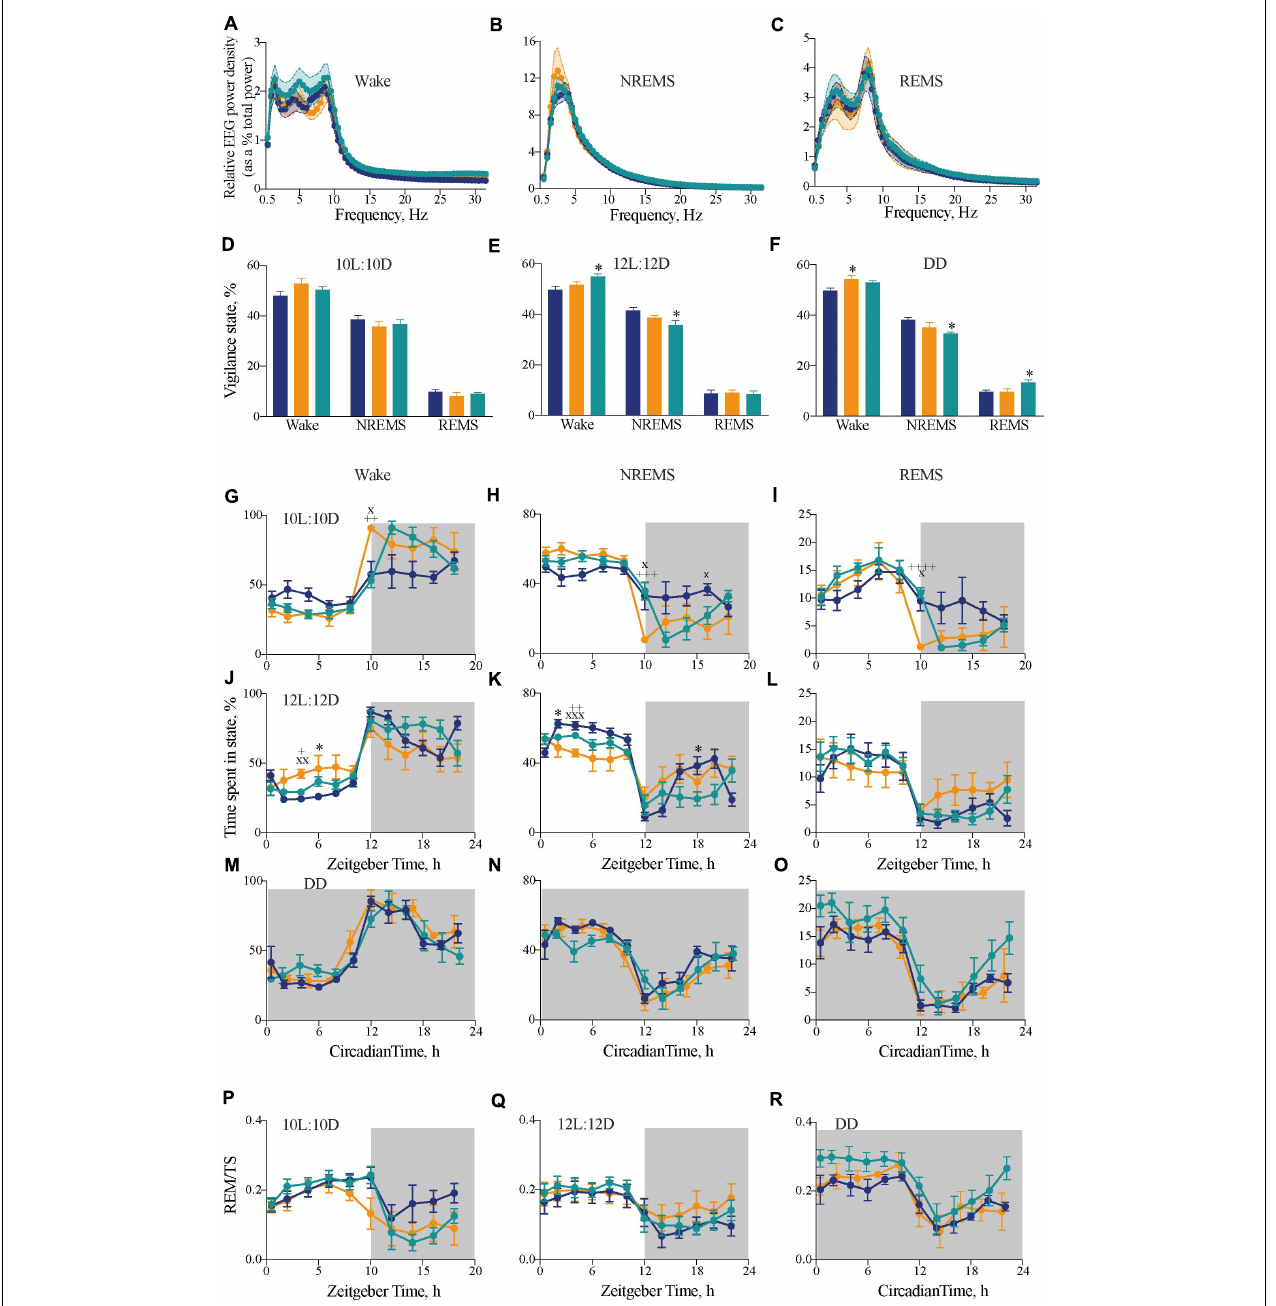
FIGURE 3 | Impact of circadian chimerism on sleep-wake cycles. (A–C) Mean ( ± SEM) relative EEG spectral power (as a percentage of total EEG power) across 0–30 Hz in wake (A) , NREMS (B) , and REMS (C) over a circadian cycle. WT (blue), Tau (orange), and chimeric (green) mice (two-way ANOVA with post hoc Tukey’s multiple comparisons test; no significant effects between Genotype or an Interaction between Genotype × Frequency in any vigilance state; n = 5–6). (D–F) Distribution of percentage time (mean ± SEM) spent in each vigilance state of wake, NREM and REM sleep under entraining conditions of 10L:10D (A) , 12L:12D (B) , and free-running conditions in DD (C) . WT (blue; n = 6–9), Tau (orange; n = 5–7), and chimeric (green; n = 6–7) mice (two-way ANOVA with post hoc Tukey’s multiple comparisons test, ∗ p < 0.05 WT vs. chimera; WT vs. Tau ). (G–L) Two hourly distribution (mean ± SEM) of percentage time spent in wake (G,J) , NREM (H,K) , and REM (I,L) sleep under entraining conditions of 10L:10D (G–I) or 12L:12D (J–L) . (M–O) Distribution of percentage time (mean ± SEM) spent in wake (M) , NREM (N) , and REM (O) sleep aligned to circadian time 12 (CT12; activity onset) under constant DD conditions. (P–R) Distribution of percentage time (mean ± SEM) spent in REMS as a percentage of total sleep (TS = NREMS + REMS) in either 10L:10D (P) , 12L:12 (Q) , or DD (R) . [WT (blue; n = 6–9), Tau (orange; n = 5–7), and chimeric (green; n = 6–7) mice]. (2x ANOVA with post hoc Tukey’s multiple comparisons test, ∗ p < 0.05, WT vs. chimera; x p < 0.05, xx p < 0.01, xxx p < 0.001 WT vs. Tau ; + p < 0.05, ++ p < 0.01, +++ p < 0.005, ++++ p < 0.0001 chimera vs. Tau